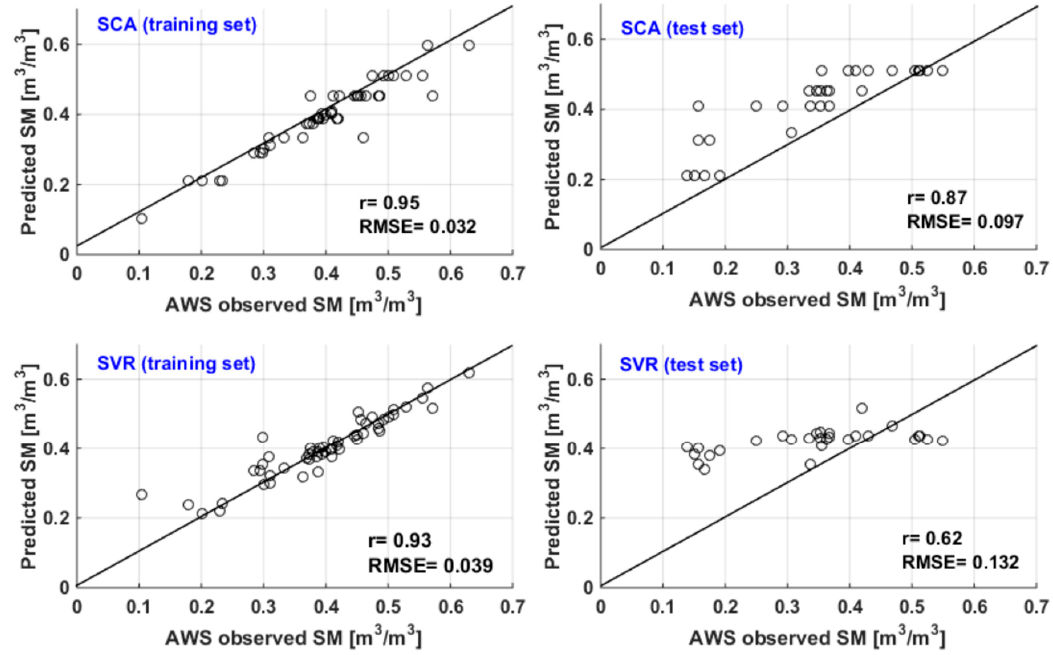
Figure 7. Prediction comparsion of SCA and support vector regression (SVR) for AWS based cluster tree.